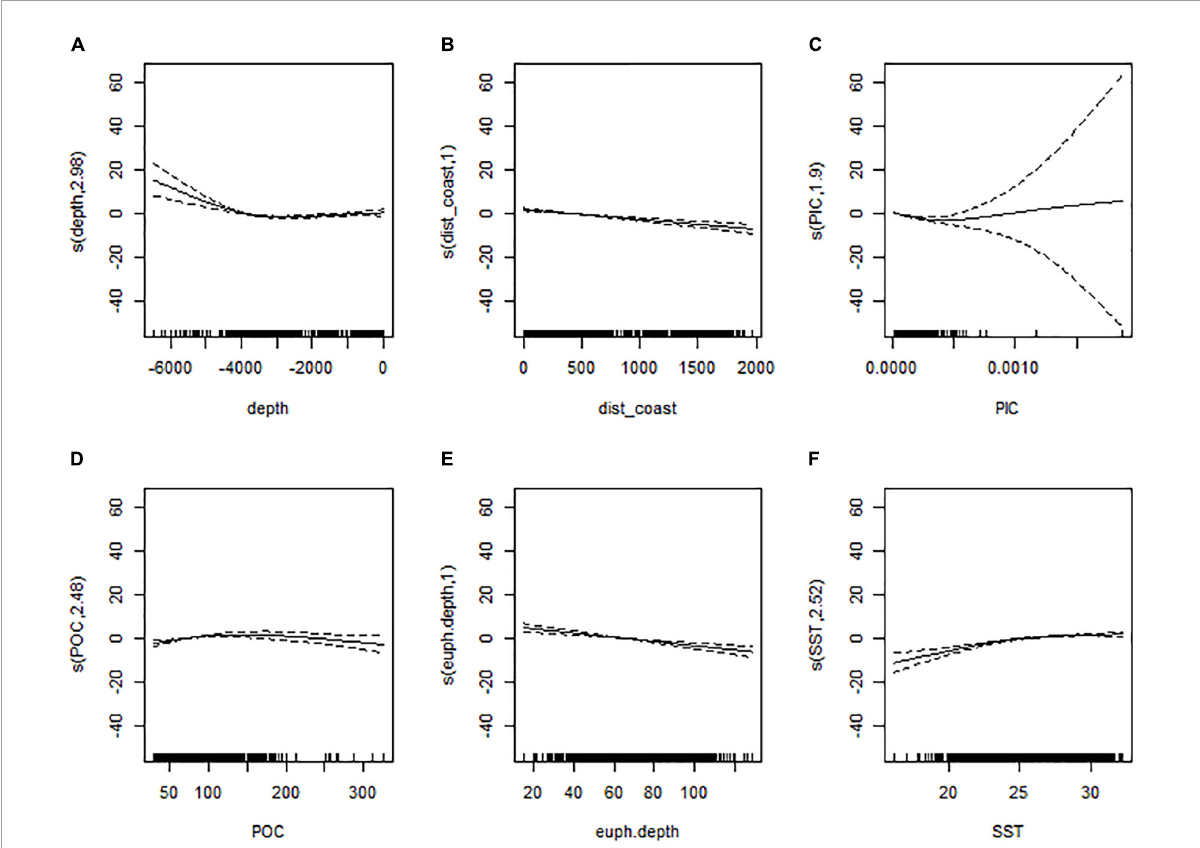
FIGURE6 Summary plot for the GAM with the highest explanatory power for the presence-absence pattern of olive ridley turtles observed in the Eastern Tropical Pacific (see also Tables 2 , 3 ). The separate panels depict how each environmental variable ( x -axis) interacts with the dependent variable presence ( y -axis): (A) water depth; (B) distance to the nearest coastline; (C) particulate inorganic carbon (PIC); (D) particulate organic carbon (POC); (E) euphotic depths; and (F) sea surface temperature (SST).